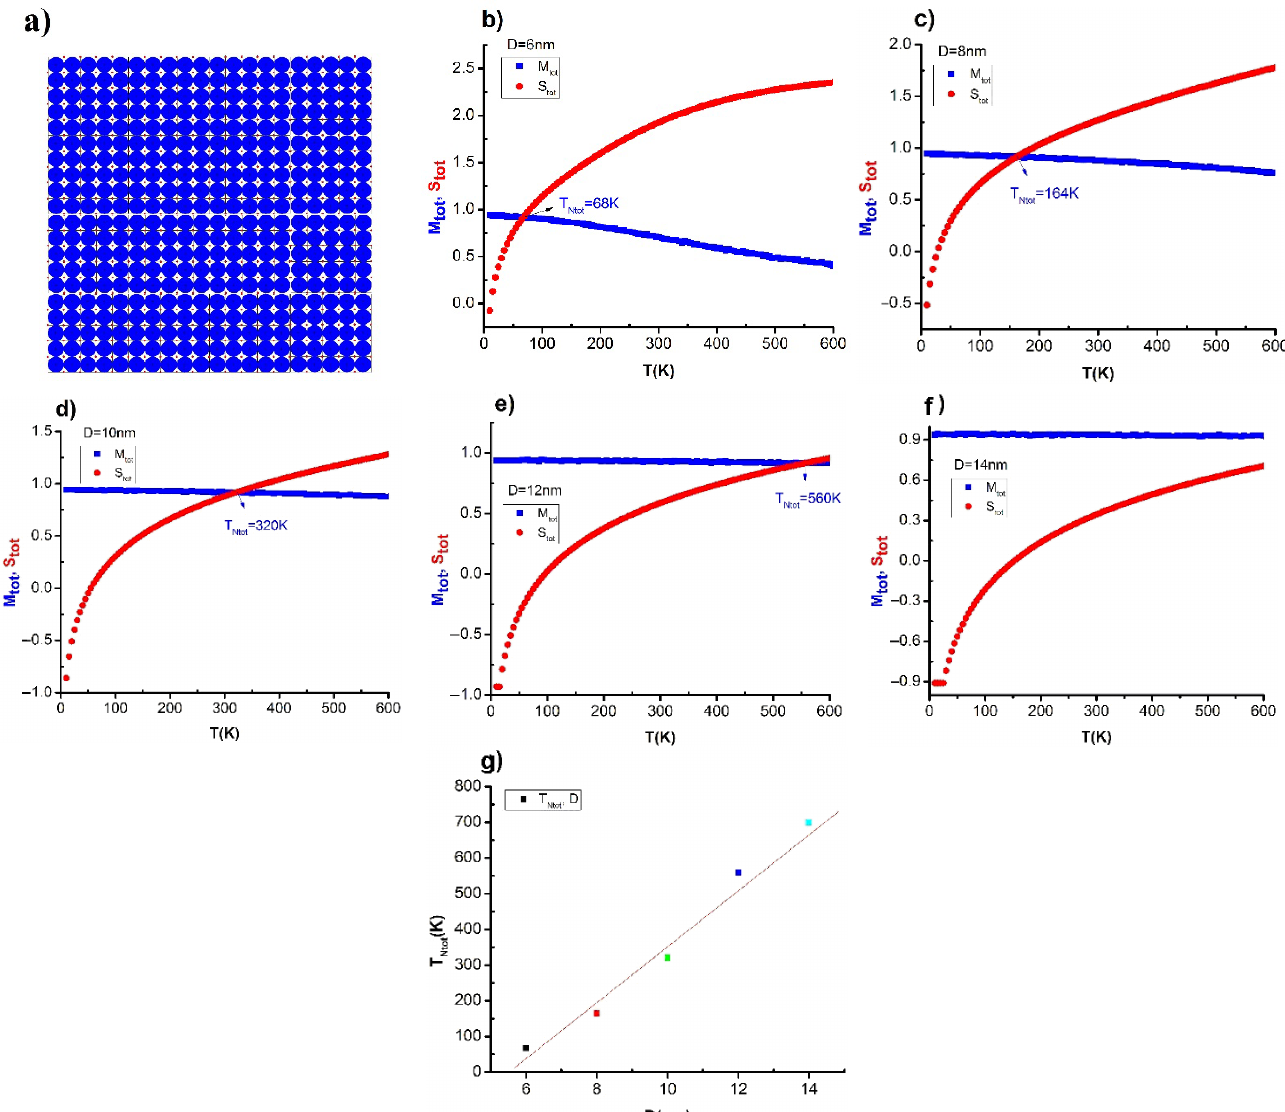
Figure 6. The Néel phase transition temperature (T Ntot ) of Fe 2 O 3 nano synthetic thin film with mxm = 20 × 20, L = 130 nm, B = 0.1 T, rotation angle α = 90° for different nanoparticle sizes: the shape ( a ), the results for the size D = 6 nm ( b ), D = 8 nm ( c ), D = 10 nm ( d ), D = 12 nm ( e ), D = 14 nm ( f ) and T Ntot depends on D ( g ).